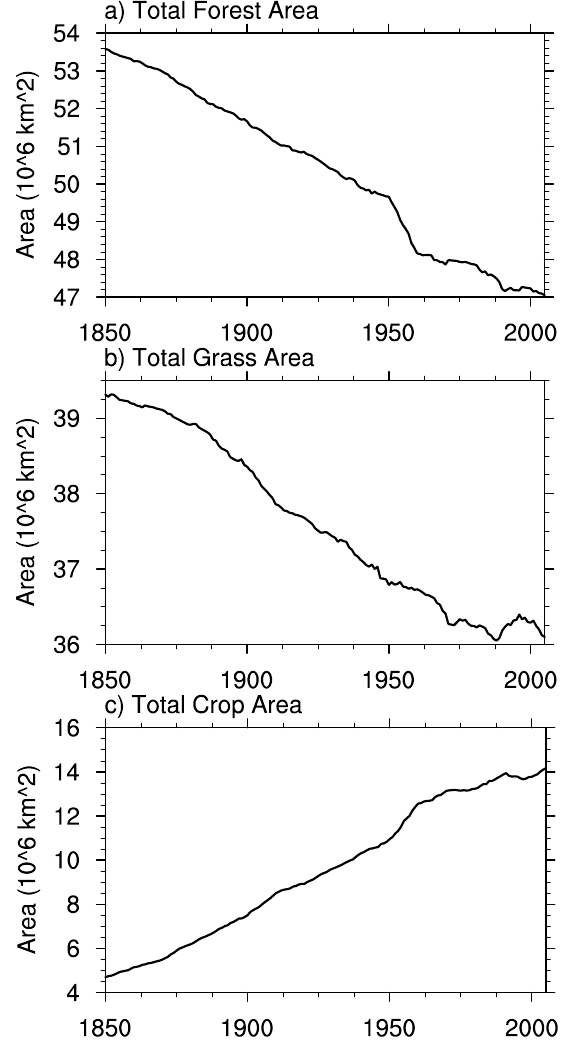
Fig. 2. CMIP-5 global historical land cover changes in land area (10 6 km 2 ) . Note that the y axis scale used for each land use category